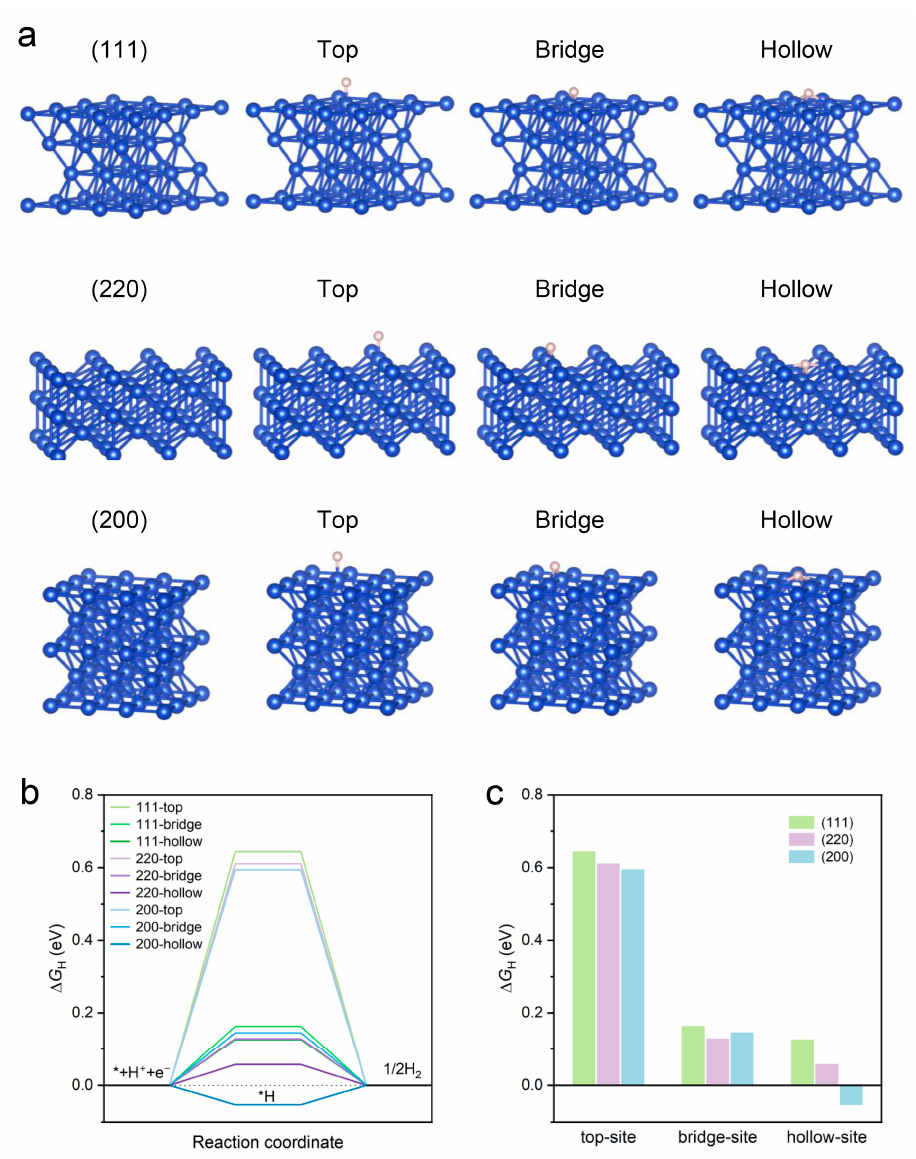
Figure 5. Adsorption energy of hydrogen on top, bridge, and hole sites of Cu (111), (220), and (200) planes. ( a ) Atomic models of hydrogen adsorption on Cu top, bridge, and hollow sites. ( b ) Free energy diagram, where * denotes the active site of the catalyst. ( c ) Δ G H values for the same sites.